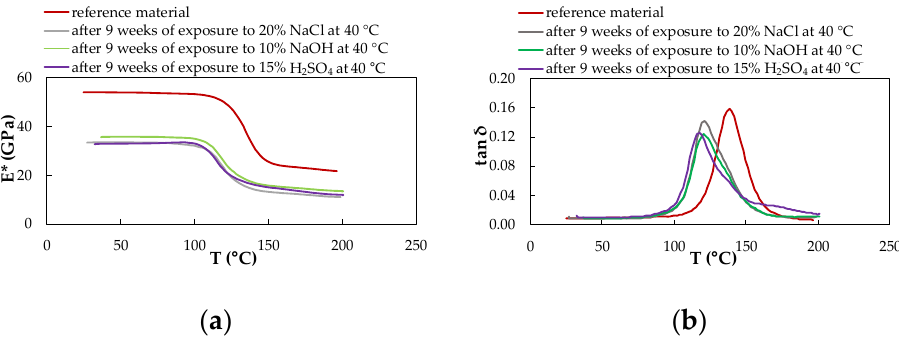
Figure 12. DMA of the CFRP composite evaluated depending on the influence of individual chemical environments at 40 °C; ( a ) complex modulus of elasticity; ( b ) tan delta. reference material after 9 weeks of exposure to 20% NaCl at 60 °C after 9 weeks of exposure to 10% NaOH at 60 °C after 9 weeks of exposure to 15% H2SO4 at 60 °C